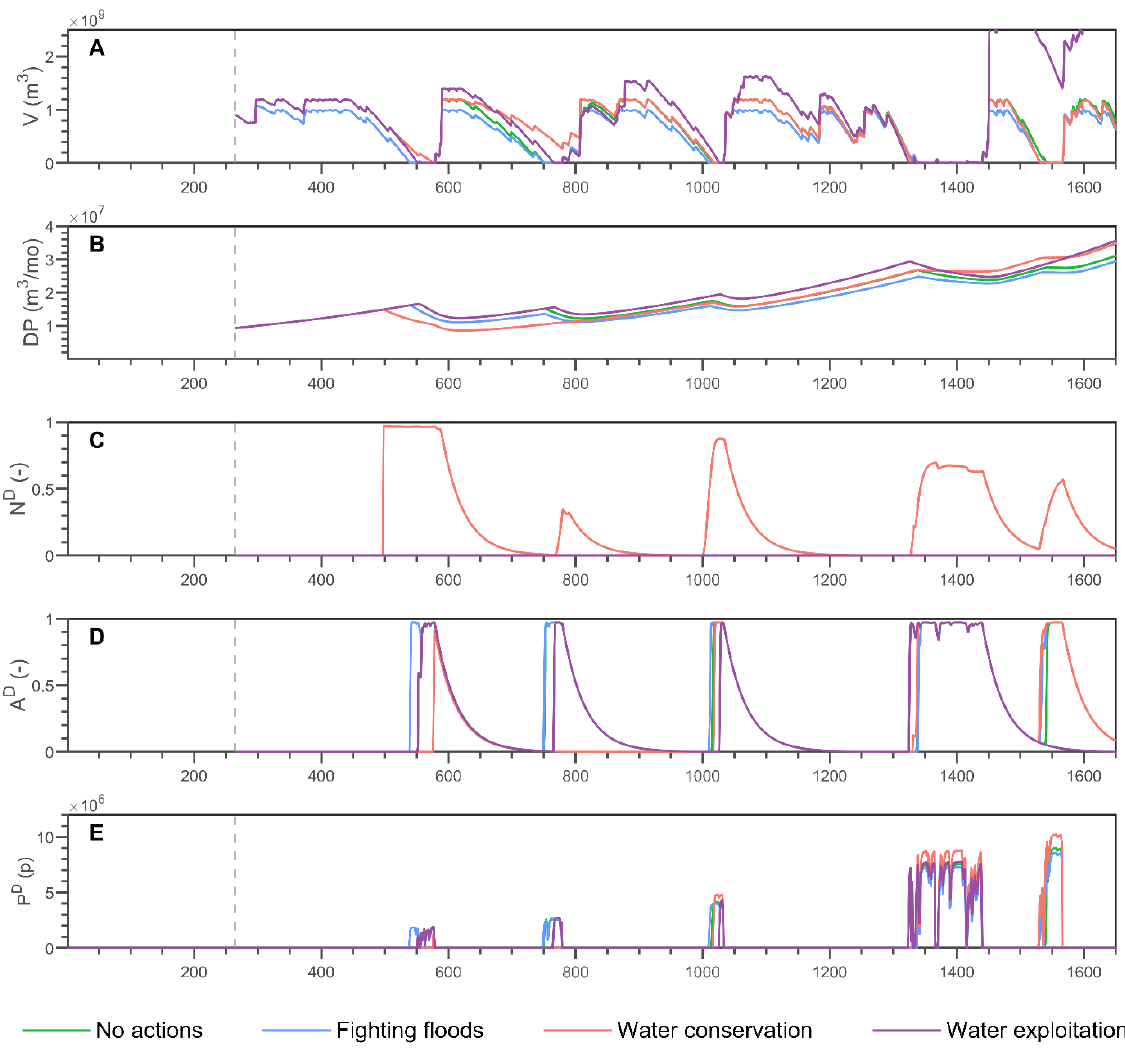
Figure A13. Water shortage-based variables of the synthetic experiments additional scenario #3 considering dam construction and human-flood interactions with the four water management strategies introduced in this study. (A) reservoir volume (V), (B) total water demand (DP), (C) willingness to the new per-capita demand (ND), (D) drought awareness (AD), and (E) population affected by droughts (PD). The grey dashed line indicates the construction of the Wivenhoe